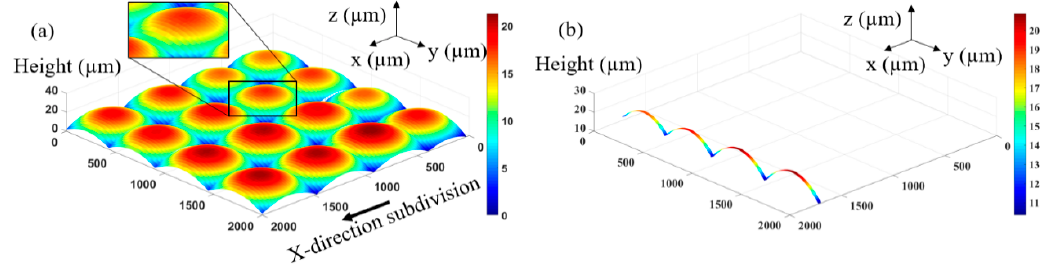
Figure 2. Surface shape of multifocal MLA: ( a ) 3D contour subdivision; ( b ) Spline surface distribution.